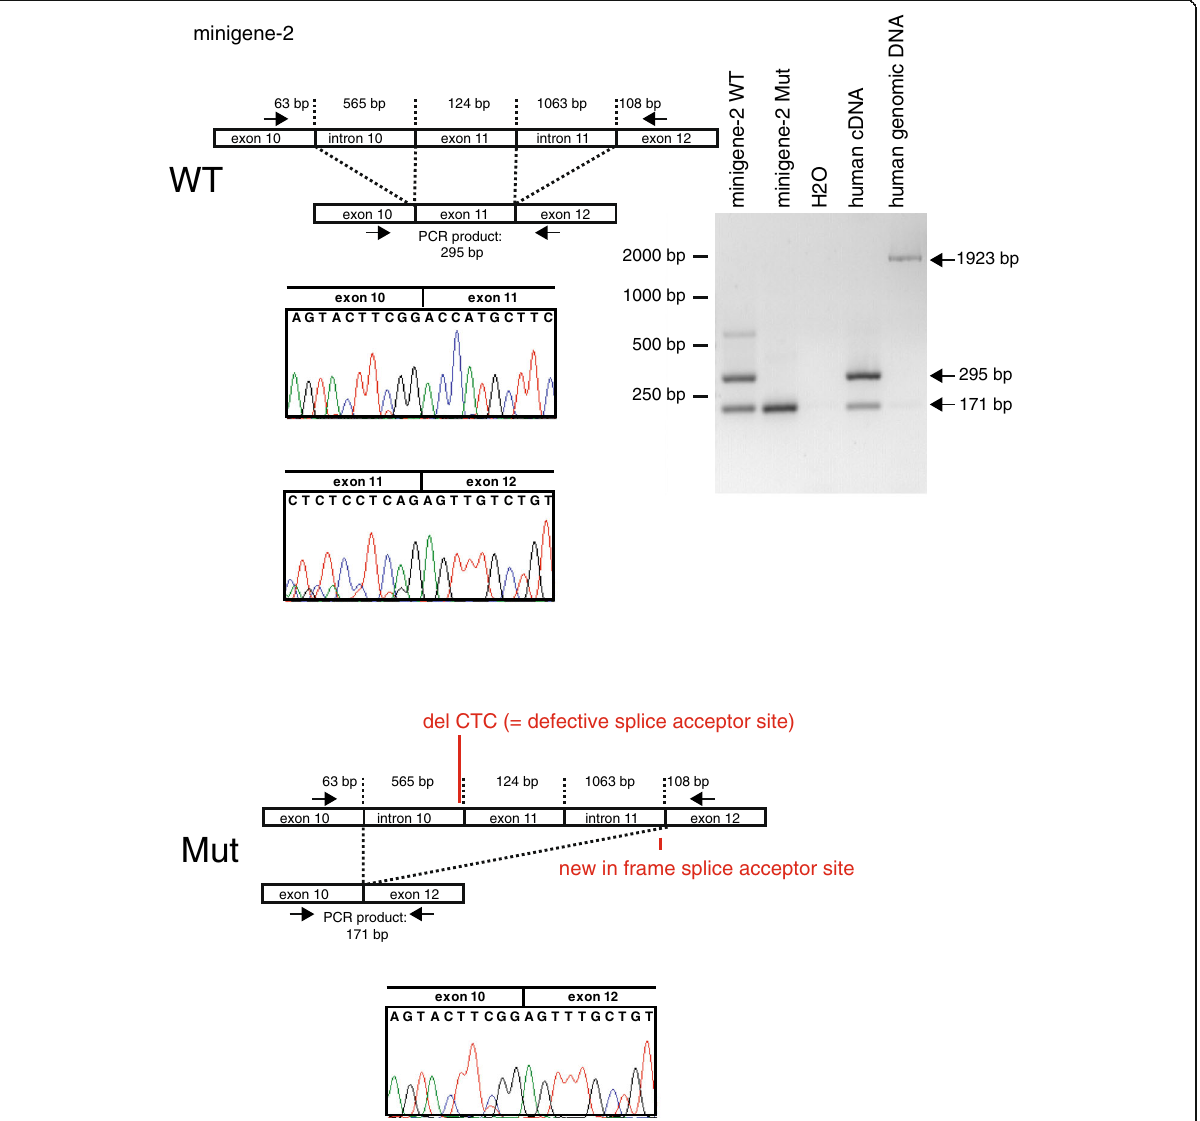
Fig. 3 To investigate the consequence of the patient mutation, minigene-2 was engineered (containing exon 10, intron 10, exon 11, intron 11 and exon 12 of human FLCN ). After transfection into mIMCD cells (of mouse origin) RNA and afterwards cDNA was prepared and subjected to sequencing and PCR. As expected, the PCR using the WT minigene-2 results (the fp and rp are located in exon 10 and exon 12, respectively) in a band of 295 bp (expected size after splicing of intron 10 (=565 bp) and intron 11 (=1063 bp)). Analysis of the mutant minigene-2 reveals that - as expected - in addition exon 11 (=124 bp) is spliced out resulting in a smaller PCR product of 171 bp. Sequencing of the PCR products reveals, that the defective splice acceptor site in front of exon11 leads to skipping of exon11. Since the splice acceptor site of exon 12 is in frame, fusion of exon 10 and exon 12 can be detected. Interestingly, also with the WT minigene-2 as well as with human cDNA skipping of exon 11 can be observed. Human cDNA and human genomic DNA served as controls for the PCR products. Sanger sequencings confirmed the results, electropherograms of the crucial junctions are